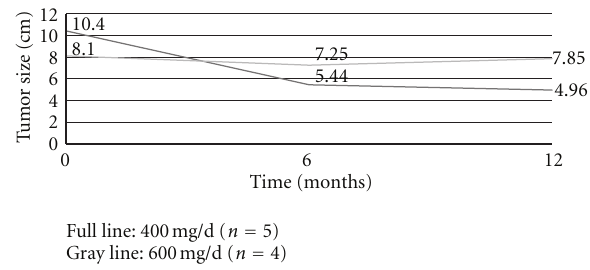
Figure 2: Mean tumour size in time in patients responding to neoadjuvant imatinib treated for 12 months ( n =